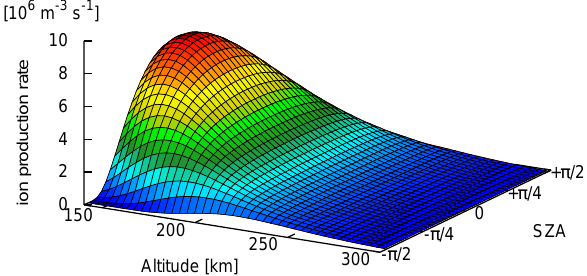
Fig. 6. Ion production rate of oxygen as a function of altitude and solar zenith angle (SZA) at solar minimum.